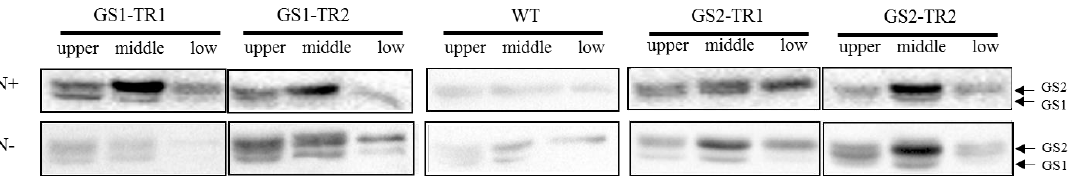
Figure 3. GS expression in the upper, middle and lower leaves of GS1-TR, GS2-TR, and the WT grown under a N+ or N − regime. Western blot analysis using various antibodies against wheat cytosolic GS1 and chloroplastic GS2.